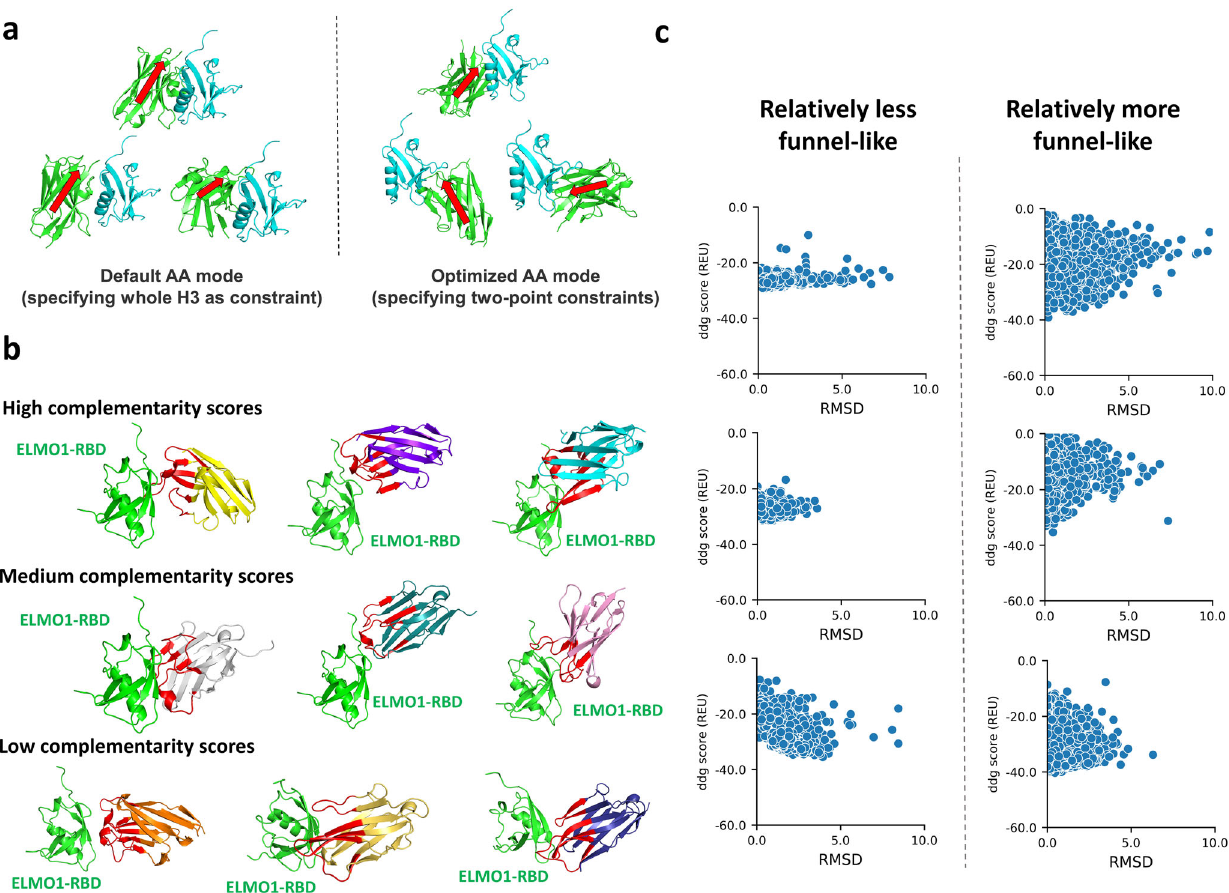
Fig. 4 Initial pose selection strategy in fi rst-round design. a Comparison of initial poses of nanobody (green) binding to ELMO1-RBD (cyan) generated by the default antibody-antigen (AA) mode and the optimized AA mode of PatchDock. Arrows (red) are approximately in parallel to the beta-strands of framework and are pointing towards the CDR loops. b Illustration of initial poses generated from the optimized AA mode in PatchDock with respect to their range of PatchDock complementarity scores among all compatible initial poses. c Comparison of the relatively less funnel-like and relatively more funnel- like binding energy landscape sampled by